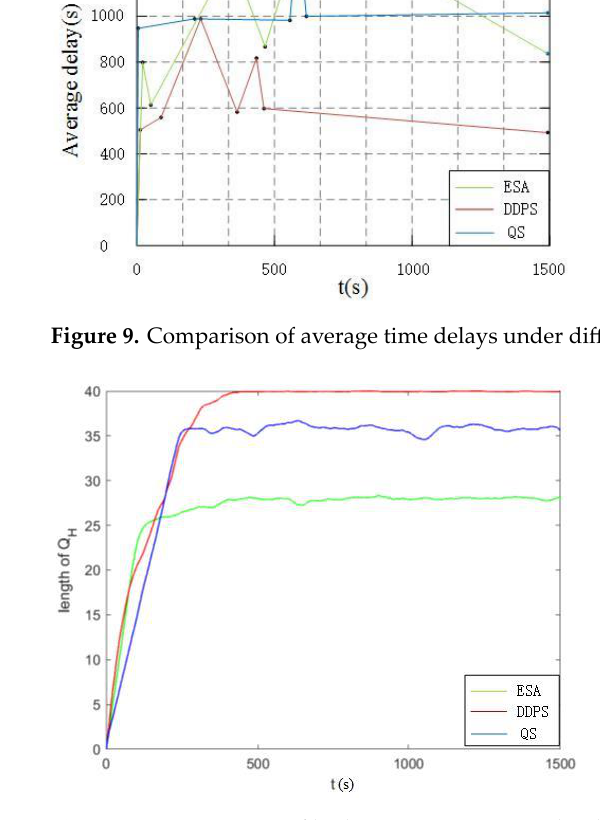
Figure 10. Comparison of high‑priority queues under different algorithms.